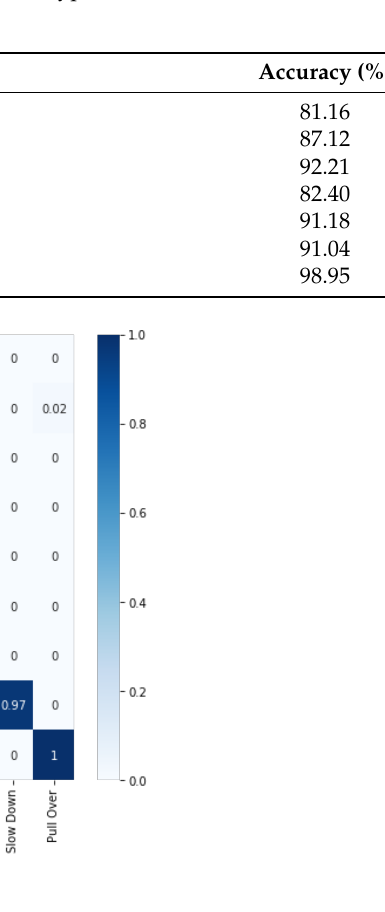
Figure 8. The confusion matrix of the proposed method on the Police Gesture Dataset. Table 4. The accuracy performance with the NTU RGB+D dataset (%).